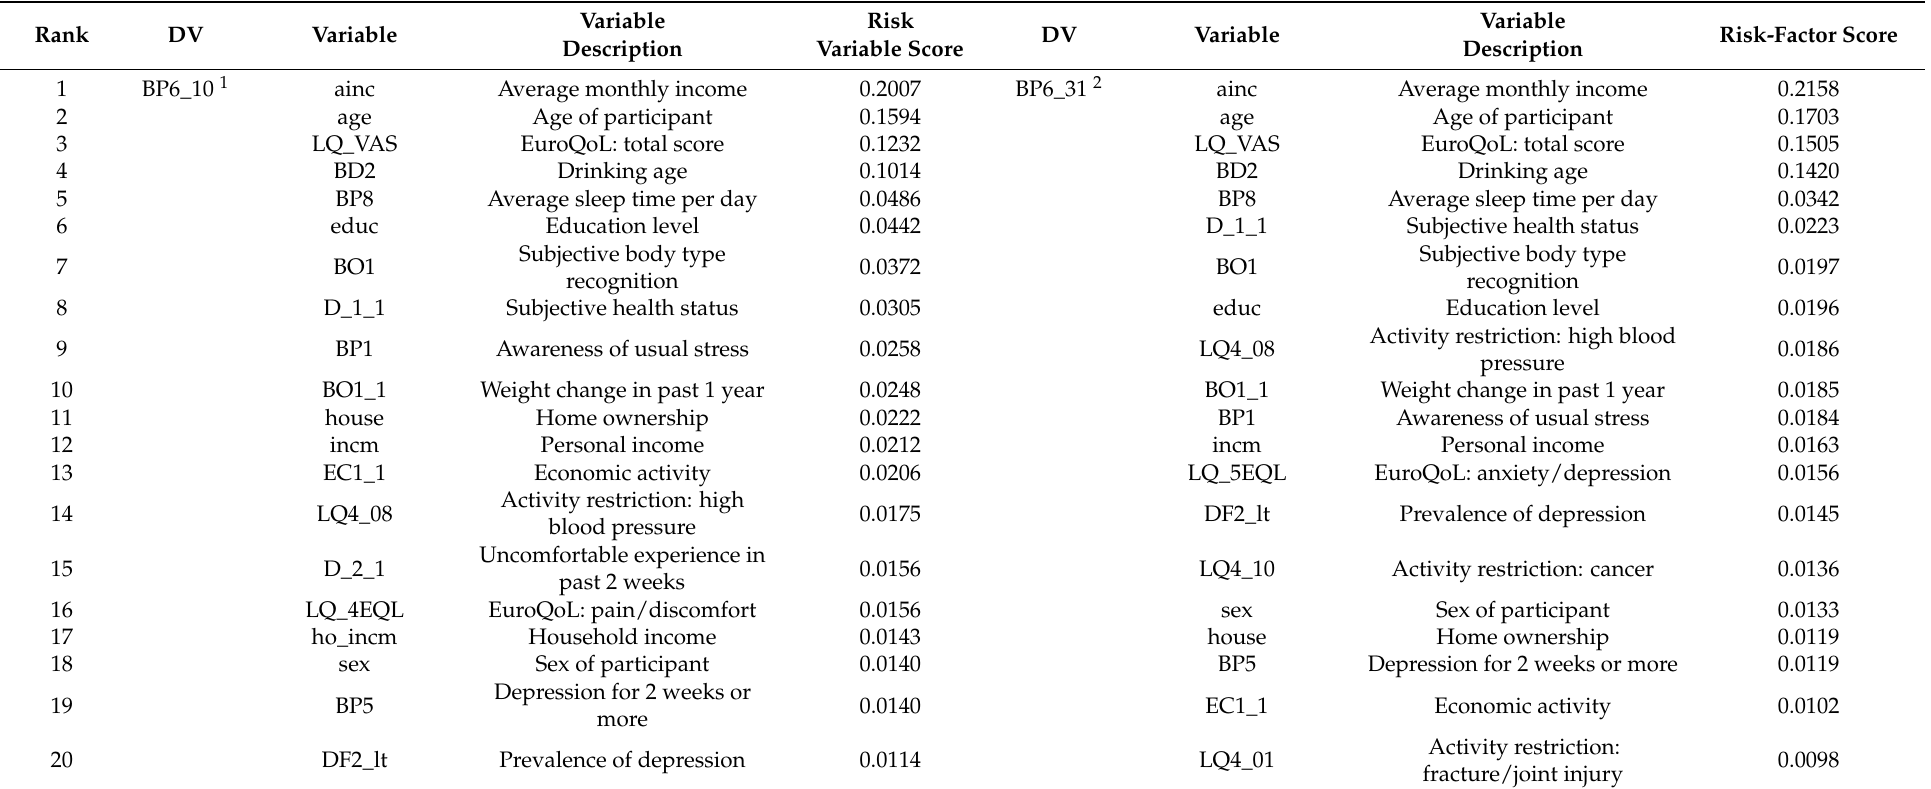
Table 10. Important features and risk-factor score in yearly dataset condition